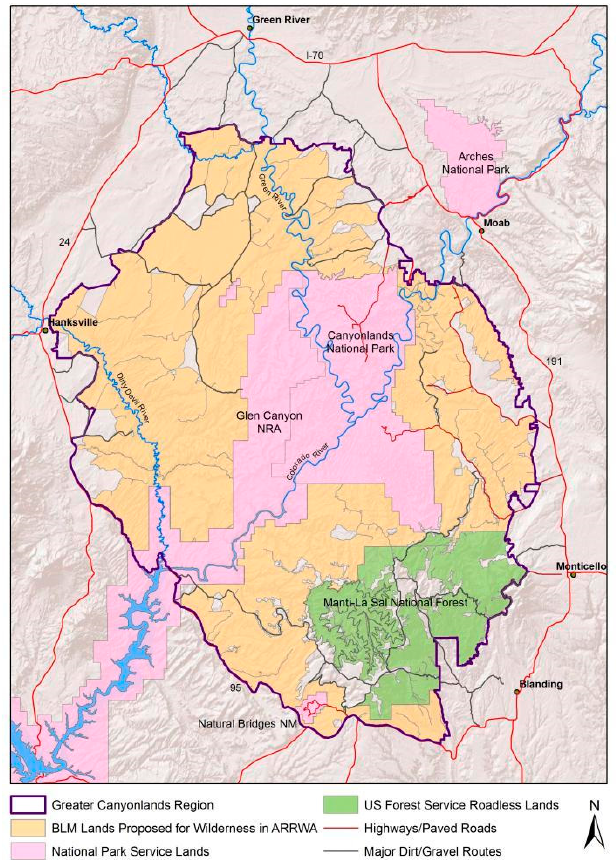
Figure 8. Boundaries for 2013 proposed Greater Canyonlands National Monument. Source: Southern Utah Wilderness Alliance .